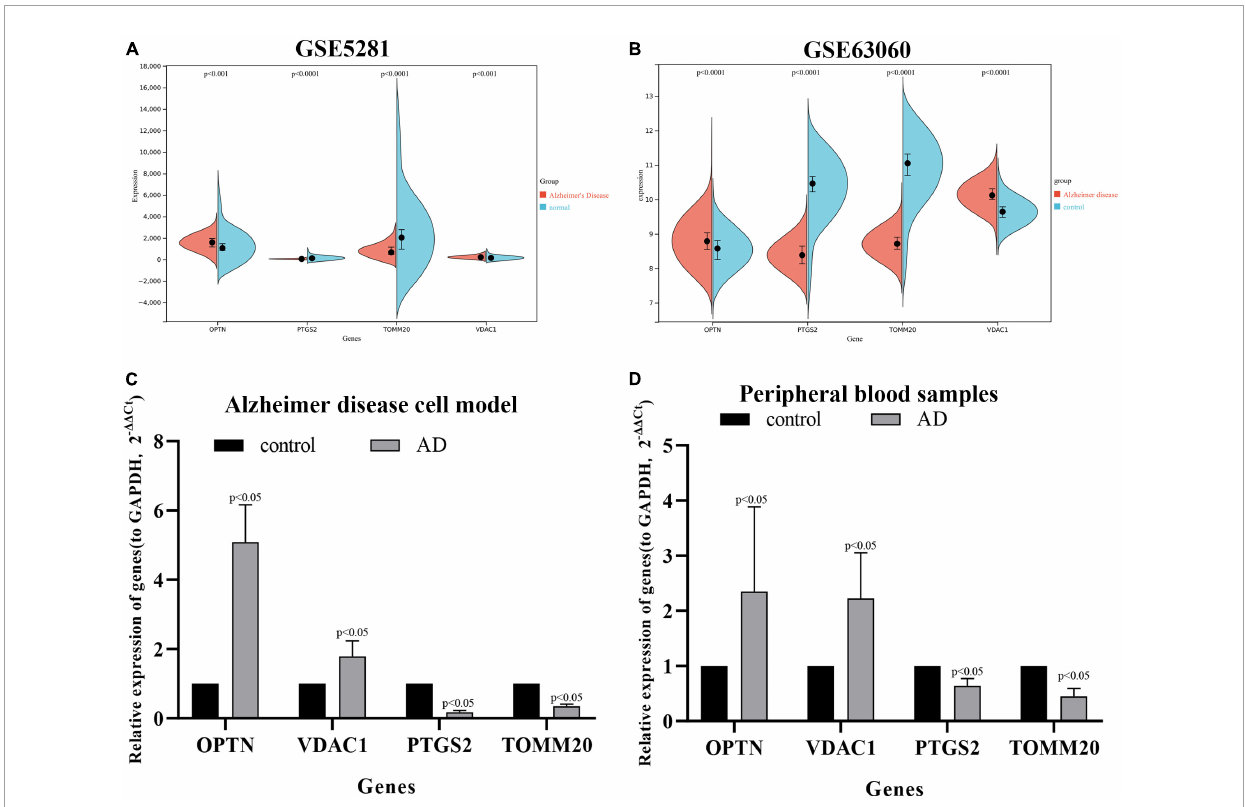
FIGURE9 Expression levels of OPTN, PTGS2, TOMM20, and VDAC1 genes in the GSE5281 dataset (A) , GSE63060 dataset (B) , Alzheimer’s disease cell model (C) , and peripheral blood samples of Alzheimer’s disease patients (D) .